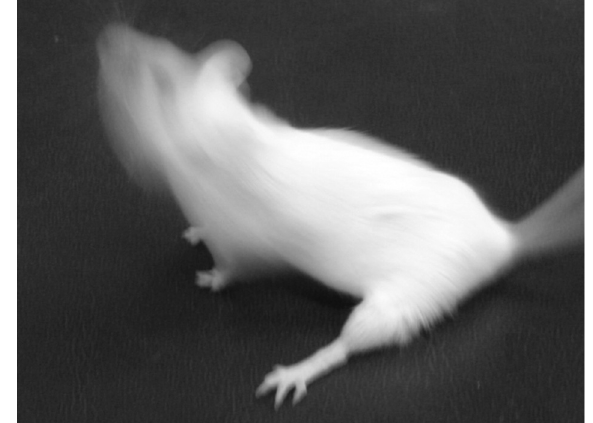
limbs, as illustrated in this photograph. The trait is most apparent when the mice are challenged with some behavioural intervention (e.g. handling for clinical